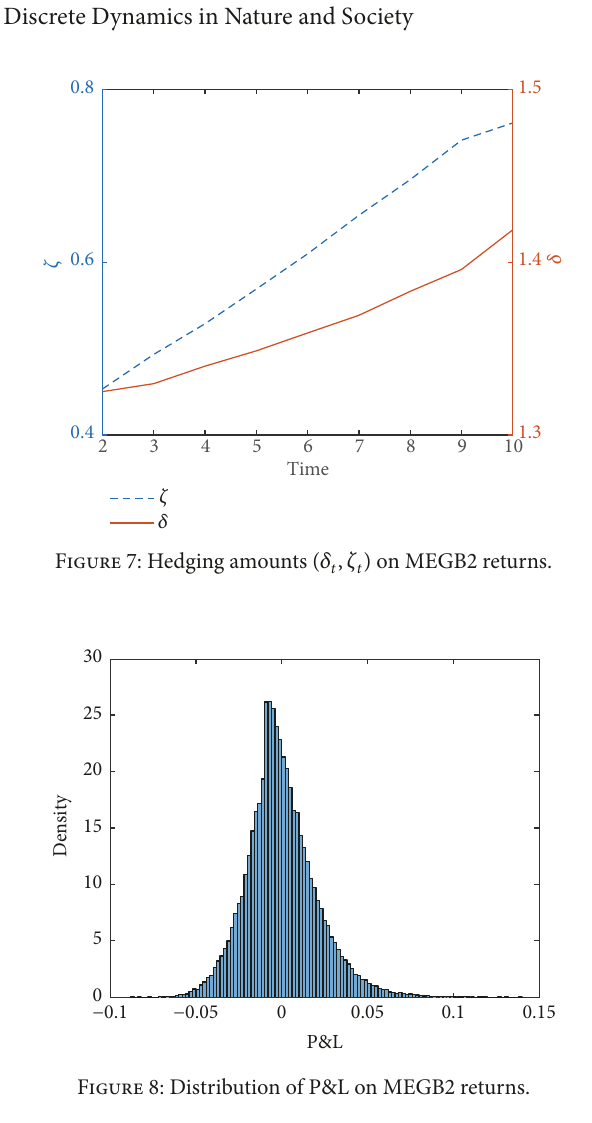
Figure 10: Distribution of P&L on MNormal